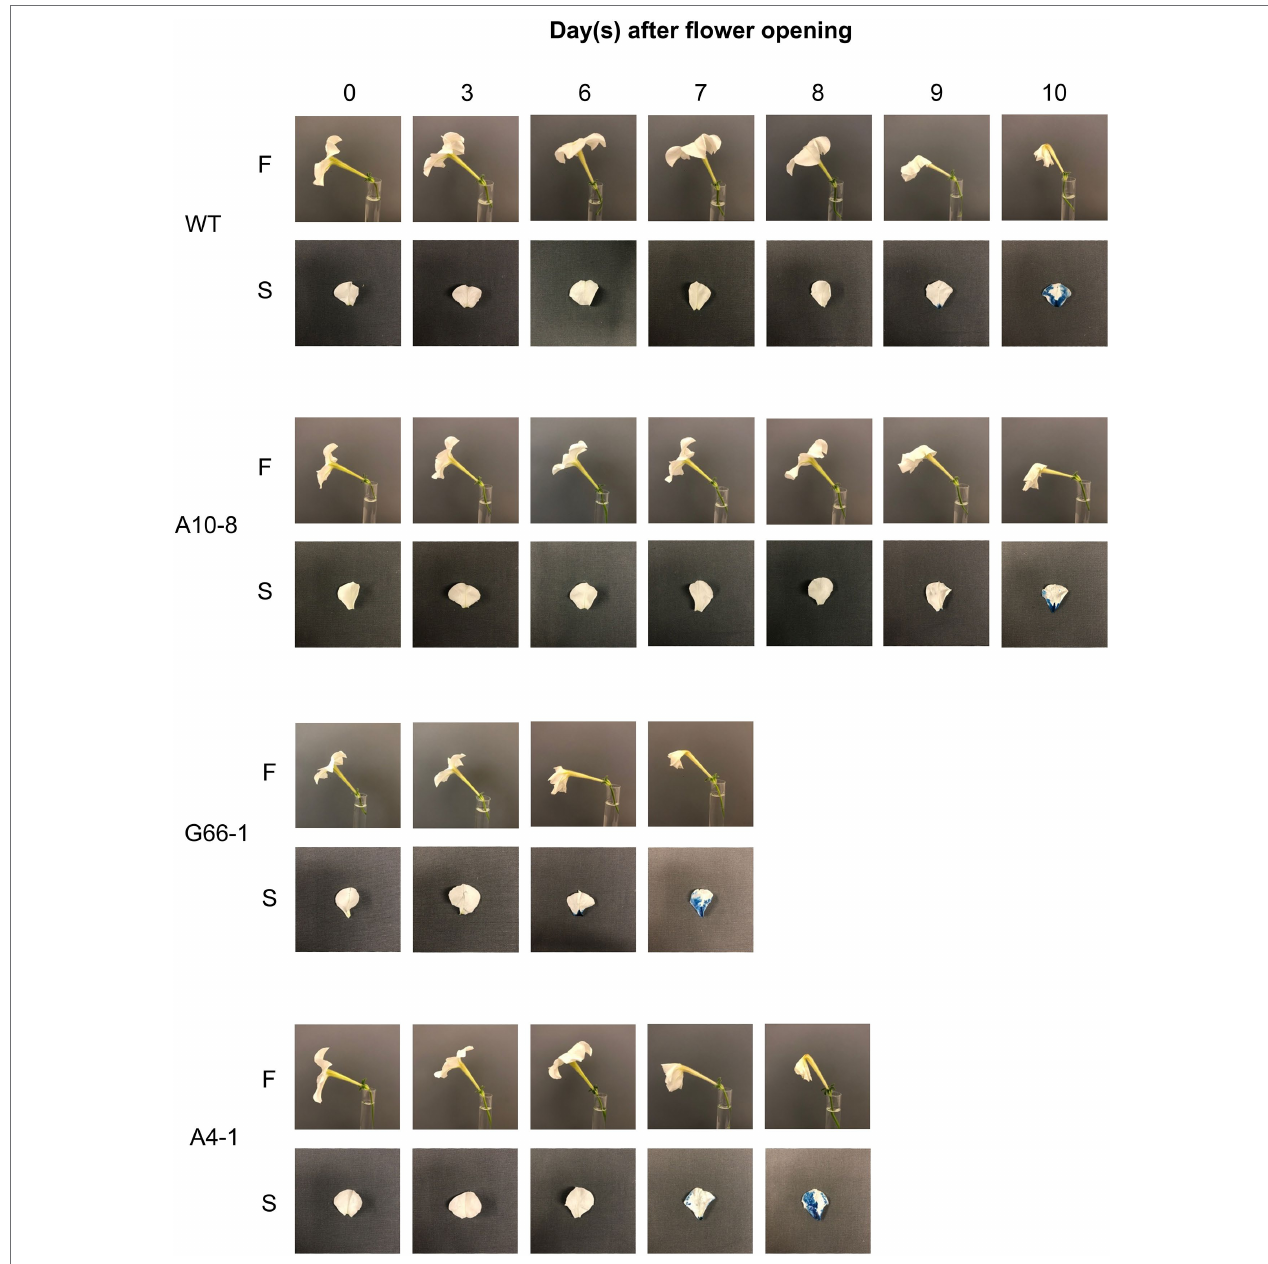
FIGURE 2 | Corolla senescence in Petunia × hybrida ‘Mitchell Diploid’ wild-type plant (WT), non-mutated regenerated line A10-8, and PhATG6 -KO lines (G66-1 and A4-1). Pictures of representative flowers (F) and Evans Blue-stained petal limbs (S) were taken from the day of flower opening (day 0) to the day of flower senescence. Additional timepoints and lines can be seen in Supplementary Figure S1